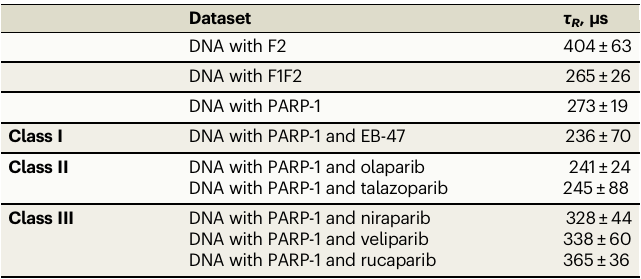
Table 1 | Interconversion times obtained from fFCS analysis for DNA in presence of PARP-1 and